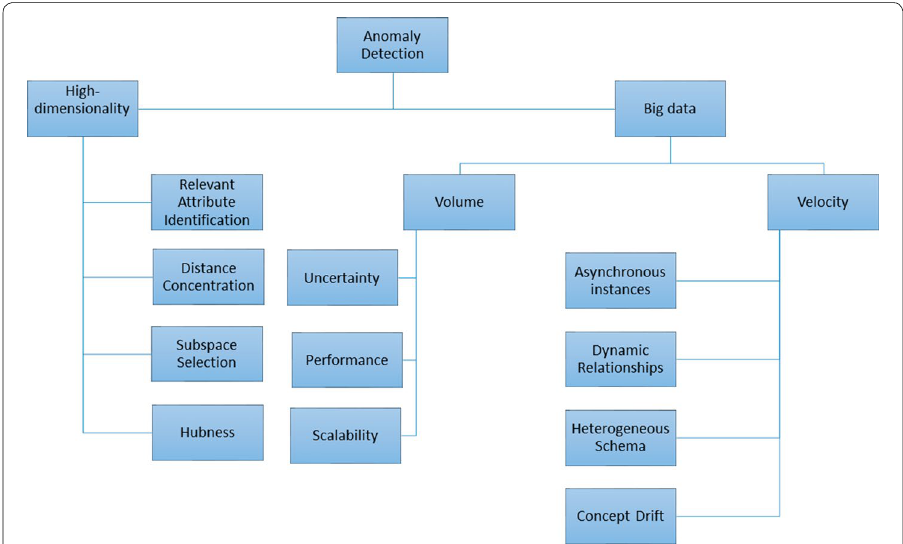
Fig. 4 Taxonomy of unique challenges brought by anomaly detection in high-dimensional big